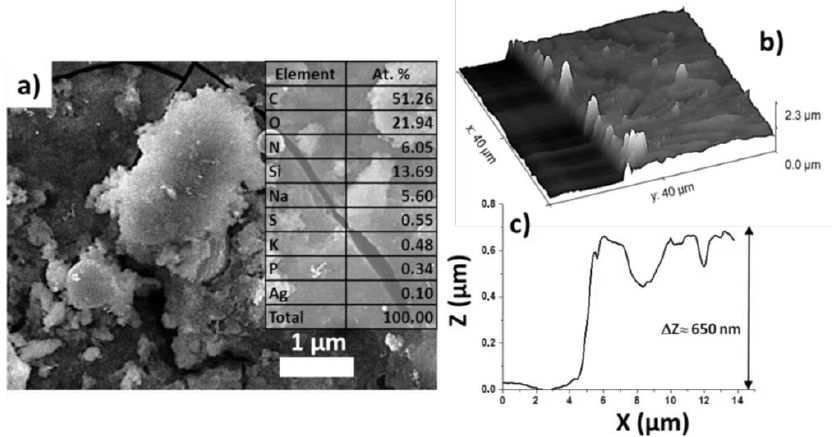
Figure 8. SEM visualization of Salmonella bacteria with transferred Ag NPs ( a ); 3D map of Salmonella biofilm with Ag NPs ( b ); biofilm–glass boundary profile ( c ).